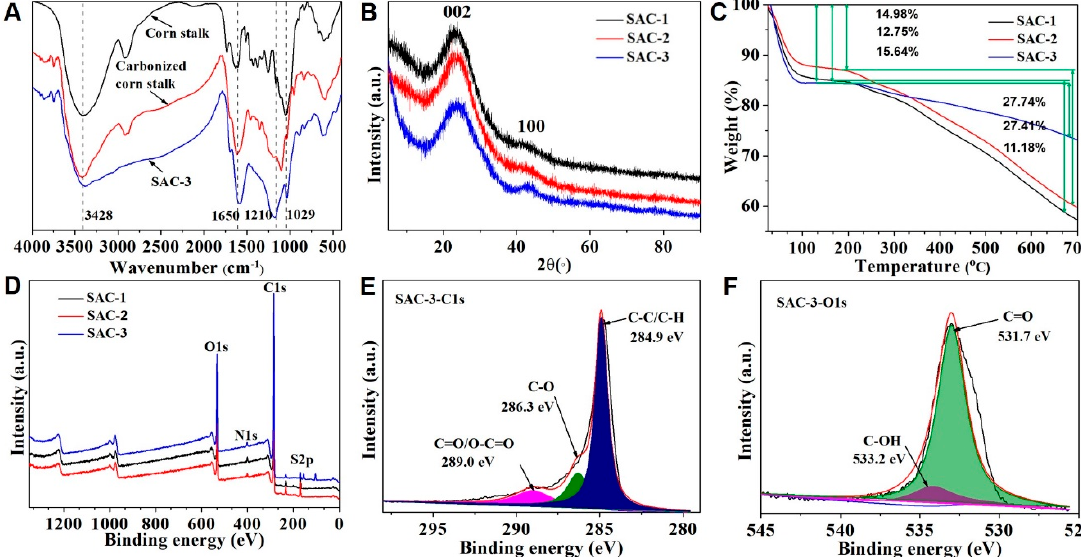
Figure 3. Structural analysis of solid acid catalysts. ( A ) FT-IR spectra; ( B ) XRD analysis; ( C ) TG analysis; ( D ) XPS analysis; XPS spectra of C1s ( E ) and O1s ( F ) of SAC-3.